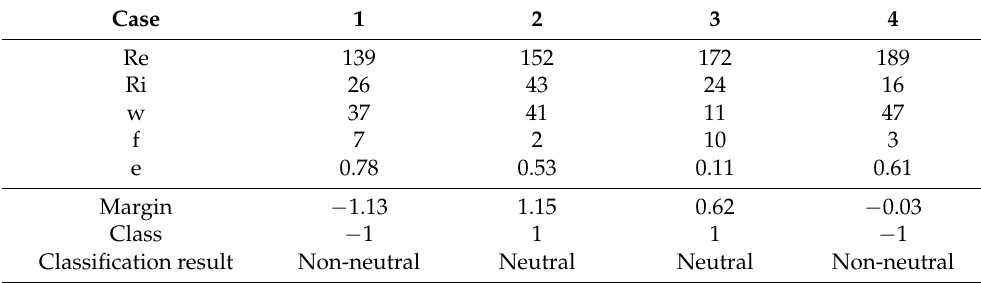
Table 5. Classification test results.